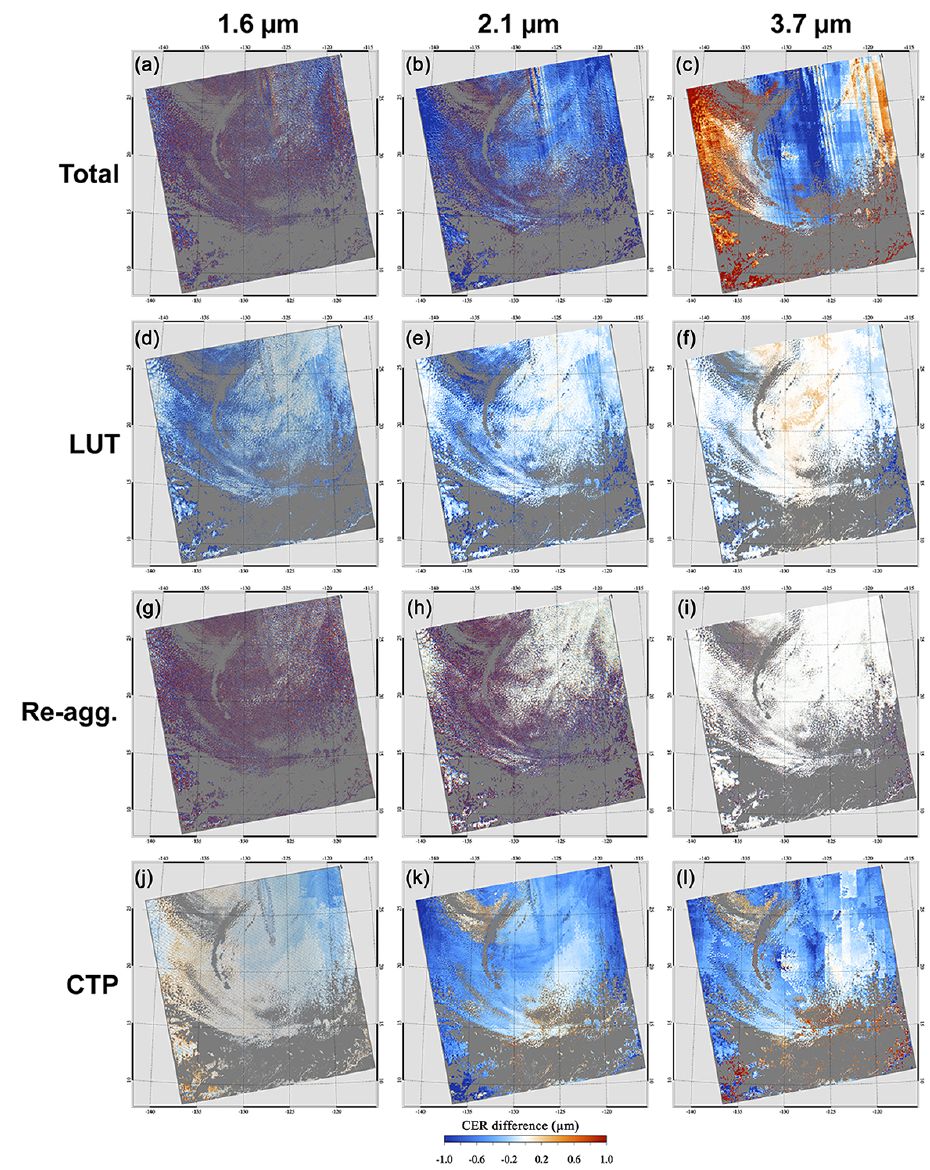
Figure 6. C6–C5.1 r e retrieval differences for the granule shown in Fig. 5 for r e 1 . 6 , r e , 2 . 1 , and r e , 3 . 7 effective radii (a–c) in total and contributions from (d–f) lookup table differences, (g–i) pixel reaggregation, and (j–l) cloud-top